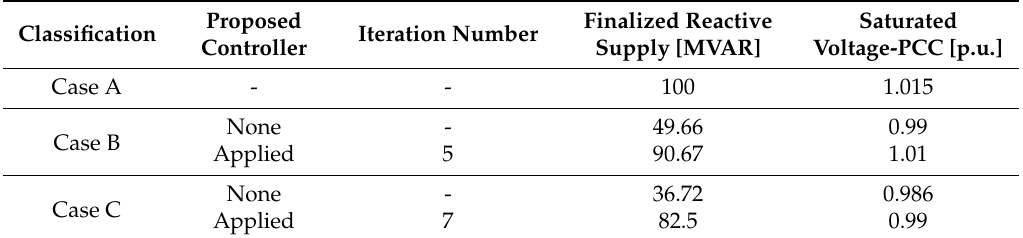
Table 4. Measured result of each case study.